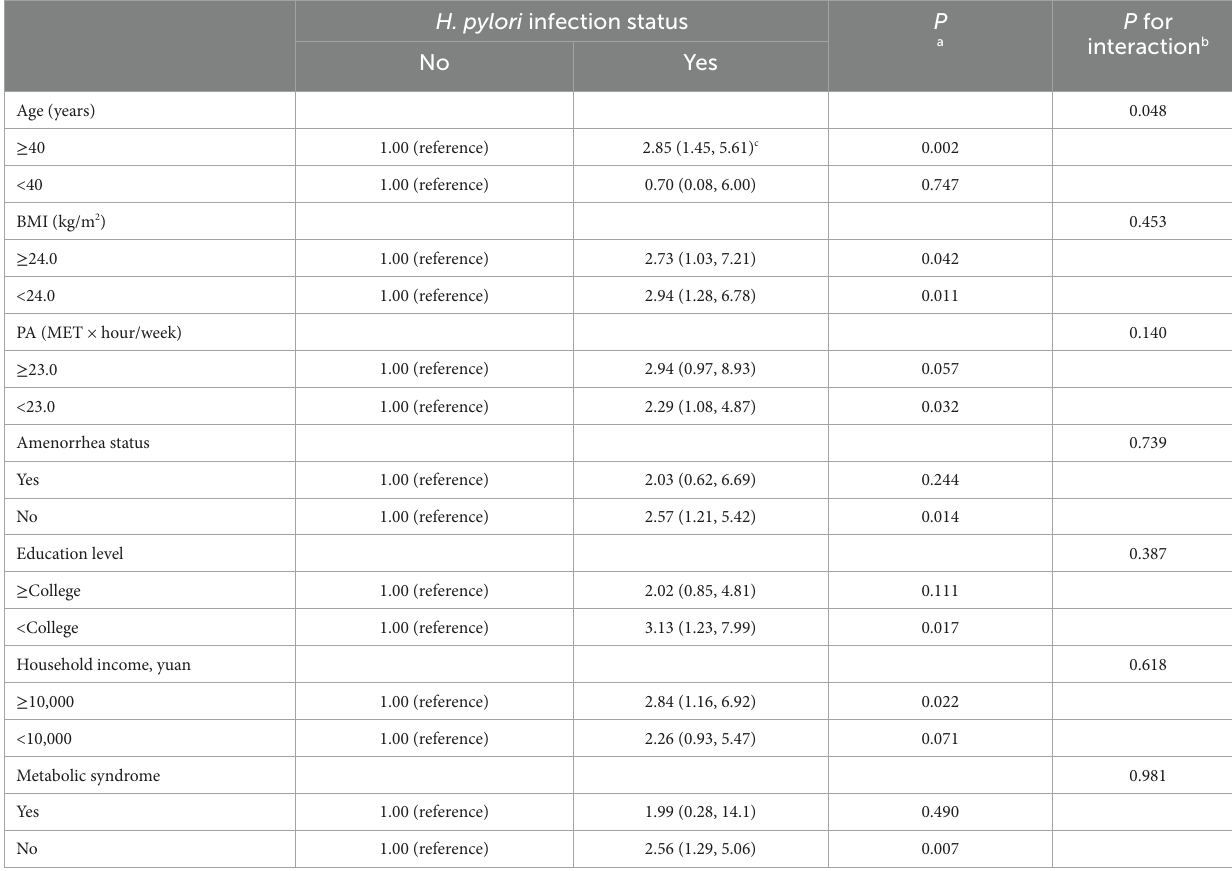
TABLE 3 Association between Helicobacter pylori infection status and risk of Subclinical hyperthyroidism in women stratified by major covariates.